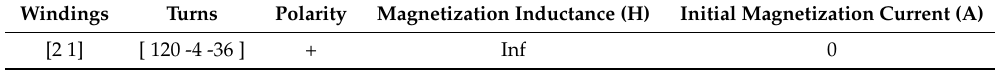
Table A3. LED Type D: Transformer parameters.